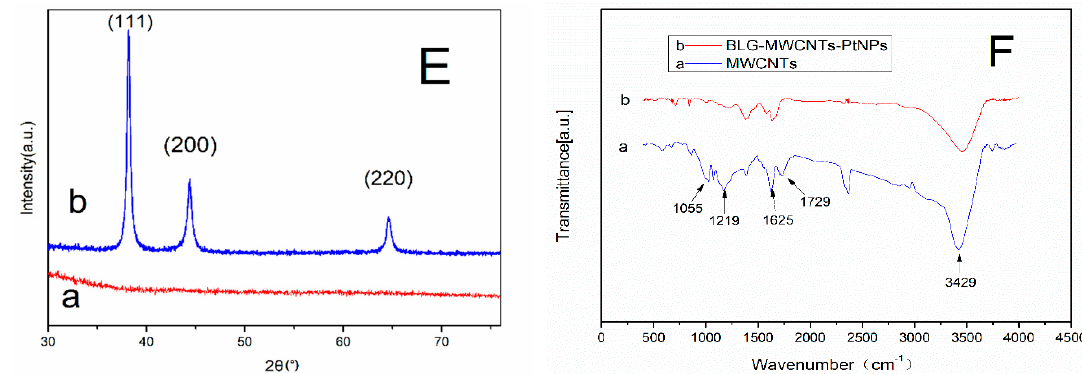
Figure 1. TEM results of MWCNTs ( A ), BLG-MWCNTs ( B ), and BLG-MWCNTs-PtNPs ( C ); EDX spectrum ( D ) of BLG-MWCNTs-PtNPs nanocomposite; XRD result of BLG-MWCNTs-PtNPs (b) and MWCNTs (a) ( E ); FT-IR result of BLG-MWCNTs-PtNPs (b) and MWCNTs (a) ( F ).